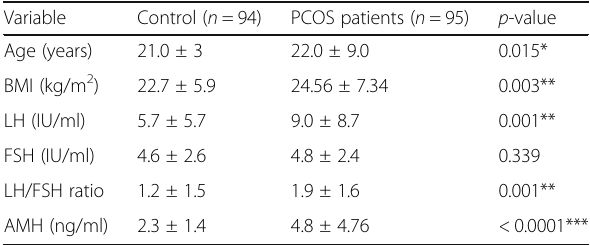
Table 1 Clinical characteristics of PCOS patients and